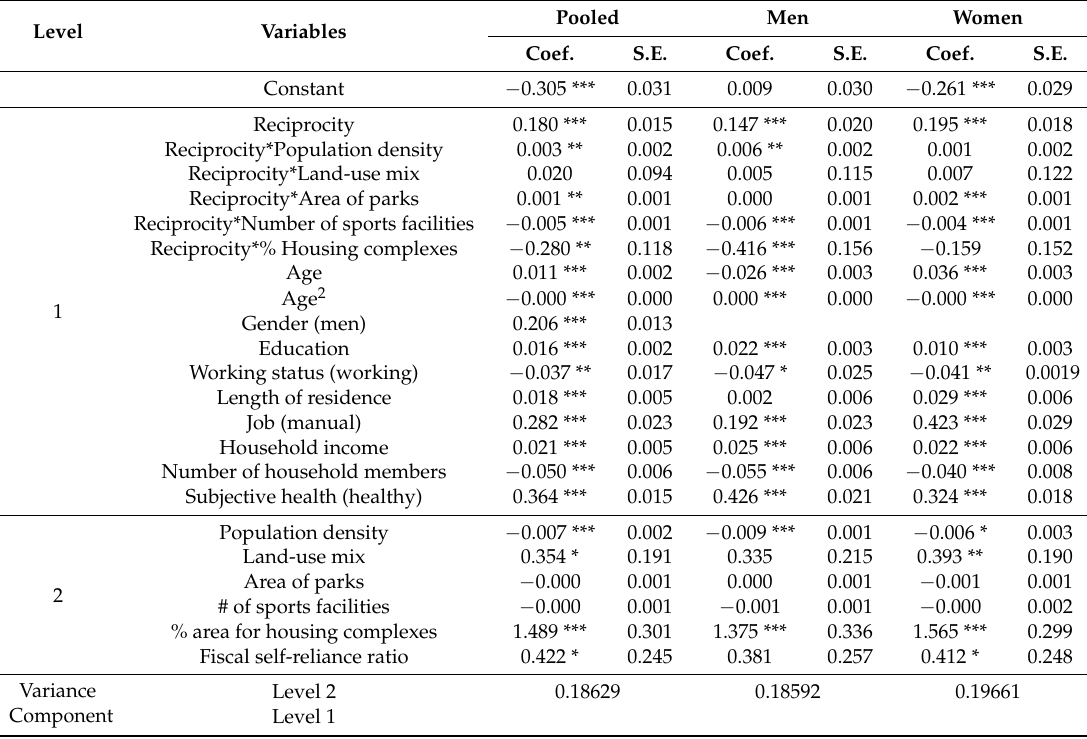
Table 4. Multi-Level Estimates: Reciprocity